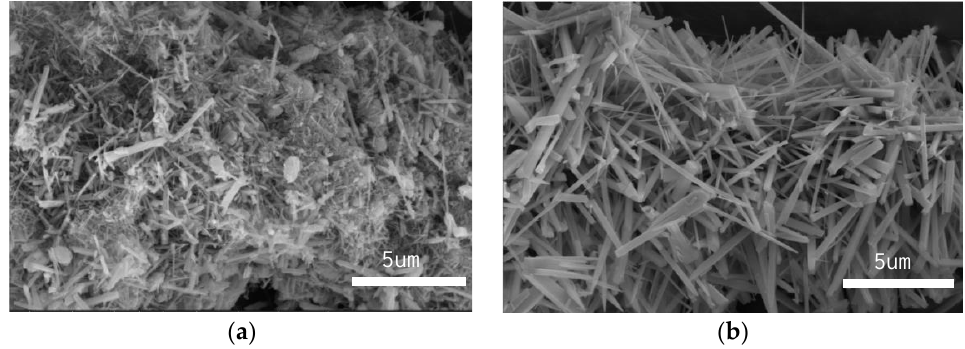
Figure 2. SEM images of mullite whiskers prepared from feedstock without rare earth oxides ( a ) and from feedstock with rare earth elements ( b ).